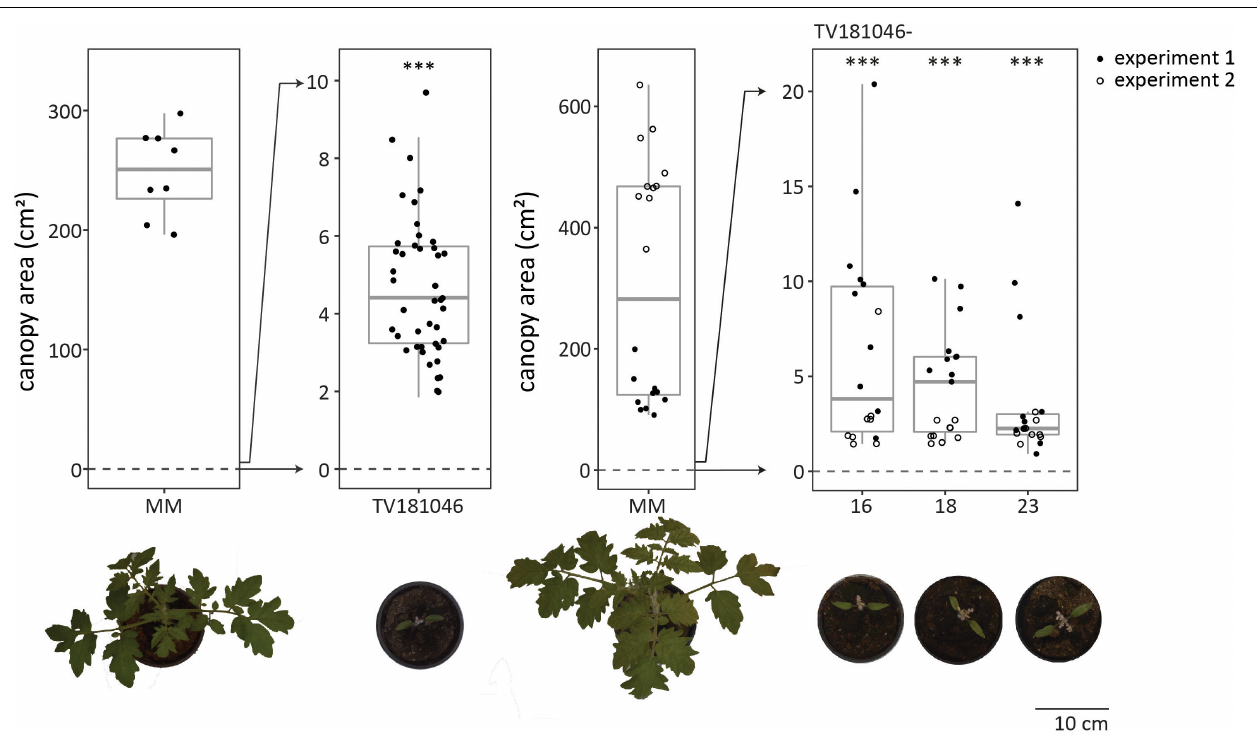
FIGURE 5 | CRISPR T2 family TV181046 and its T3 progeny display severe growth and development defects. Canopy area of mock-inoculated plants at 21 dpi for T2 CRISPR line TV181046 (left) and T3 CRISPR lines TV181046-16, –18, and –23 (right). Data from one or two independent experiments with n ≥ 8 ( t -test compared with MM with ∗∗∗ p =